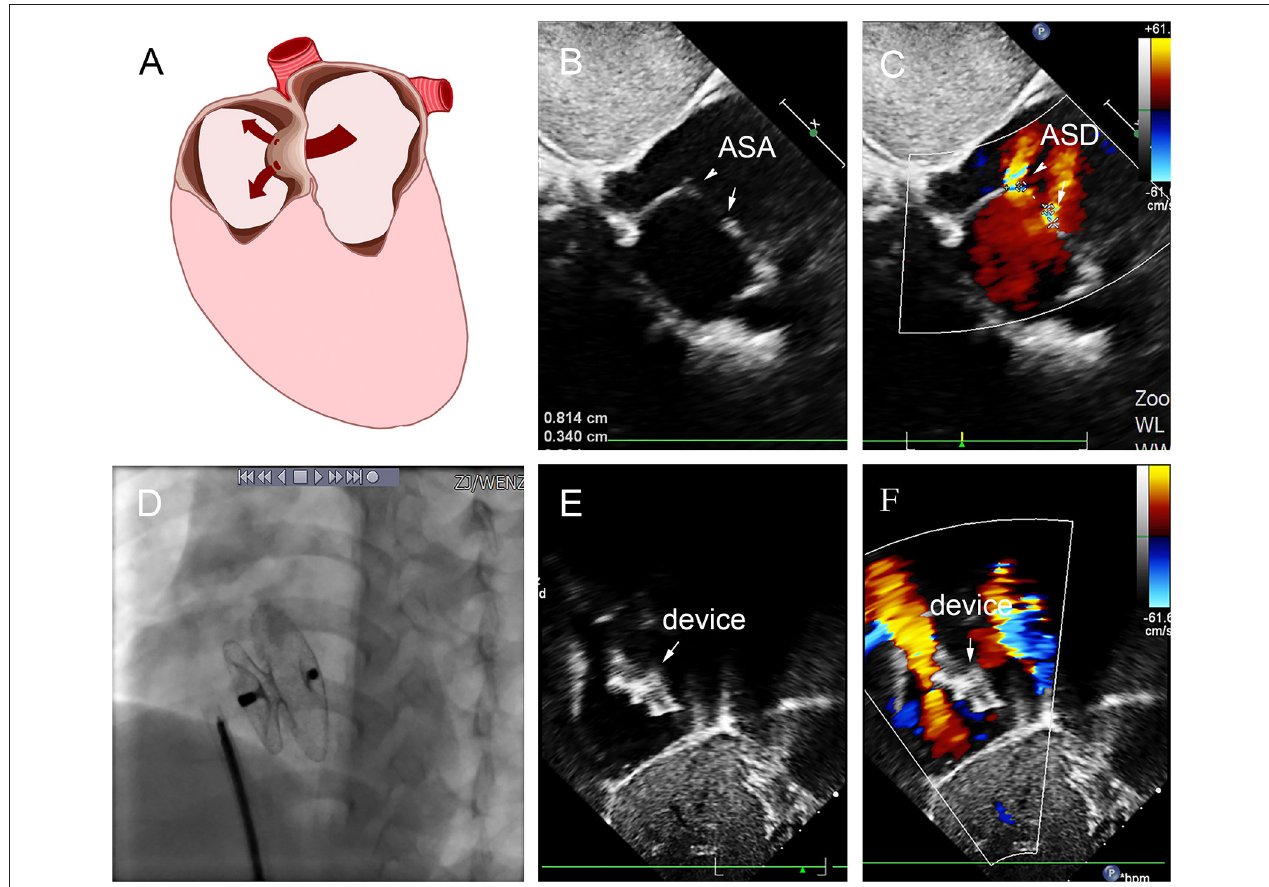
FIGURE 7 | Group D: a 2-year-old girl had double defect (A) ; the diameters of defects were 2.8 and 3.4mm, and the diameter of aneurysm base was 10mm (B,C) . We chose an 8mm small-waist–big-edge ASDO (D) had no residual shunt (E,F) and any complication at the immediate and last follow-up. ASD, atrial septal defect; ASA, atrial septal